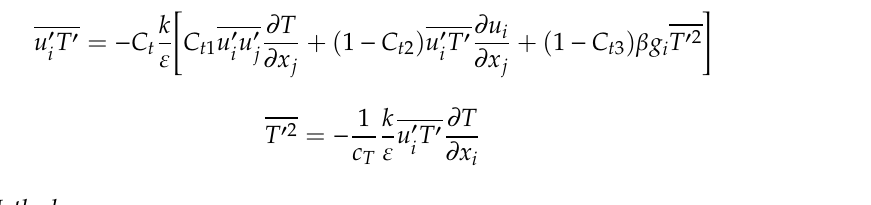
Figure 3. Computational meshes. Table 1. Initial/boundary conditions of simulations. Case